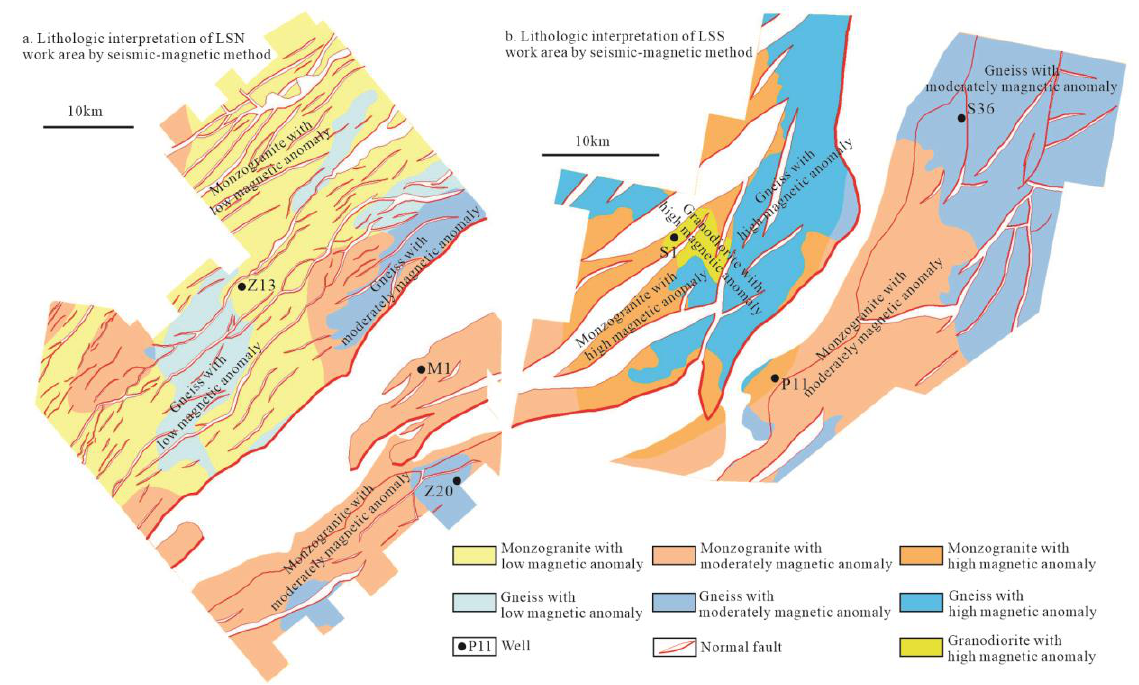
Figure 10. Distribution of basement rocks in the LS depression. Note: ( a , b ) are lithologic interpretations of basement of LSN and LSS work areas respectively based on the magnetic anomaly distribution magnetic anomaly distribution of the reduction-to-pole magnetic anomaly data extended down 4km and the lithologic interpretation of basement based on waveform classification.